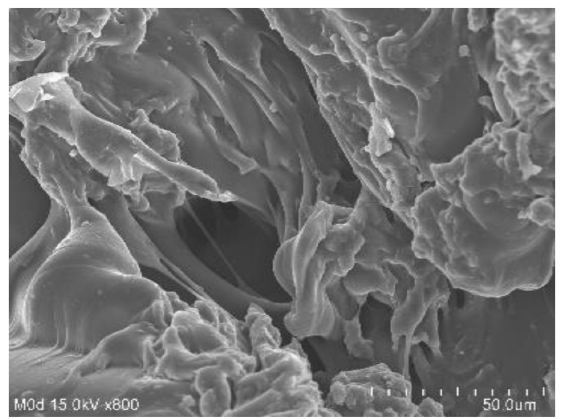
Figure 5. Scanning electron microscopy of CP/SpScPAA